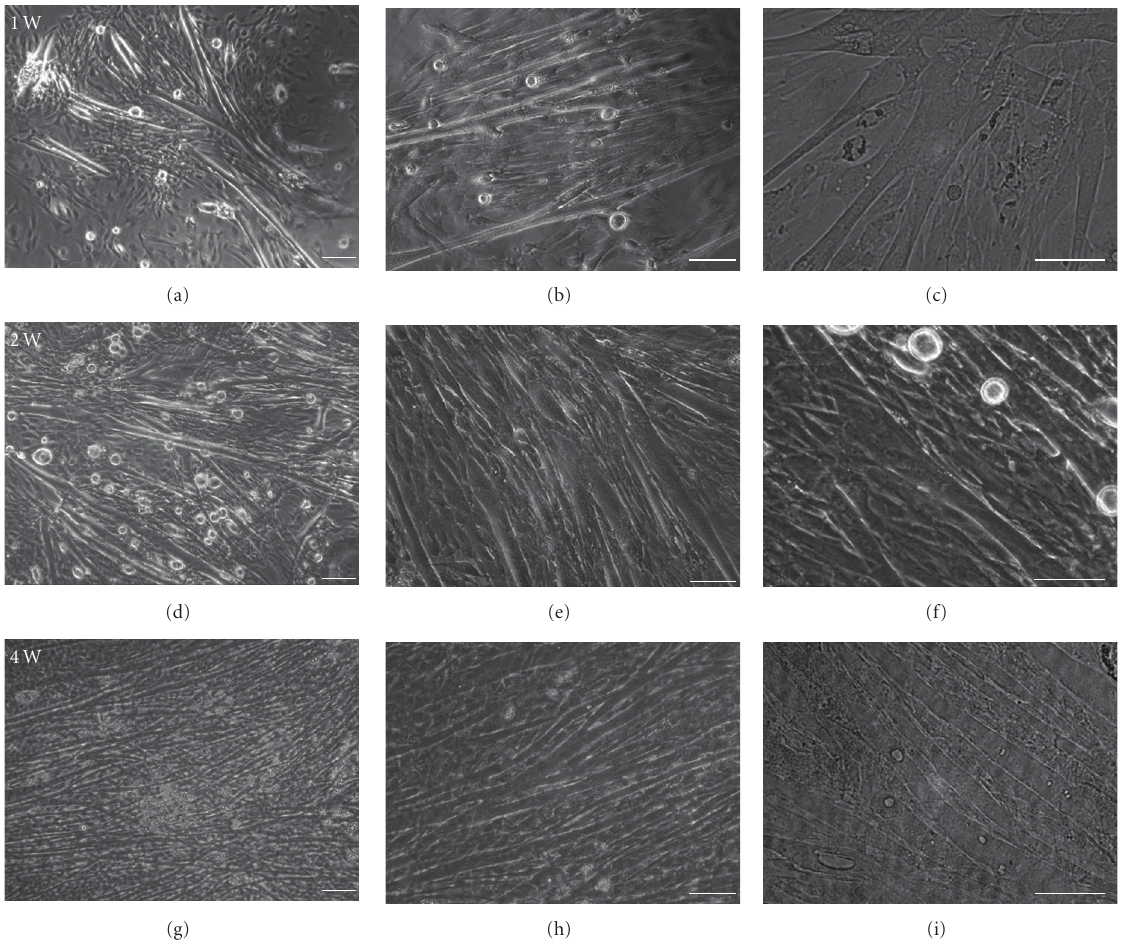
Figure 3: Culture and di ff erentiation of brown adipose-derived cardiac stem cells. Phase-contrast microscopy of di ff erentiated cardiomyocytes- like cells at days 7, 14, and 28. Isolated primary cells were plated into culture dished (2 . 5 × 10 4 cells /cm 2 ) and observed every day under an inverted phase-contrast microscope at (a)–(c) 1 weeks after spontaneous di ff erentiation, (d)–(f) 2 weeks after spontaneous di ff erentiation, (g)–(i) 4 weeks after spontaneous di ff erentiation. Di ff erentiated cells gradually increased in size with time due to cell proliferation. Early, di ff erentiated cells were rare in plates (day 7), then elongated cells appeared (day 14 and 28) more and more, and they could spontaneously beat like functional cardiomyocytes (bar = 100 μ